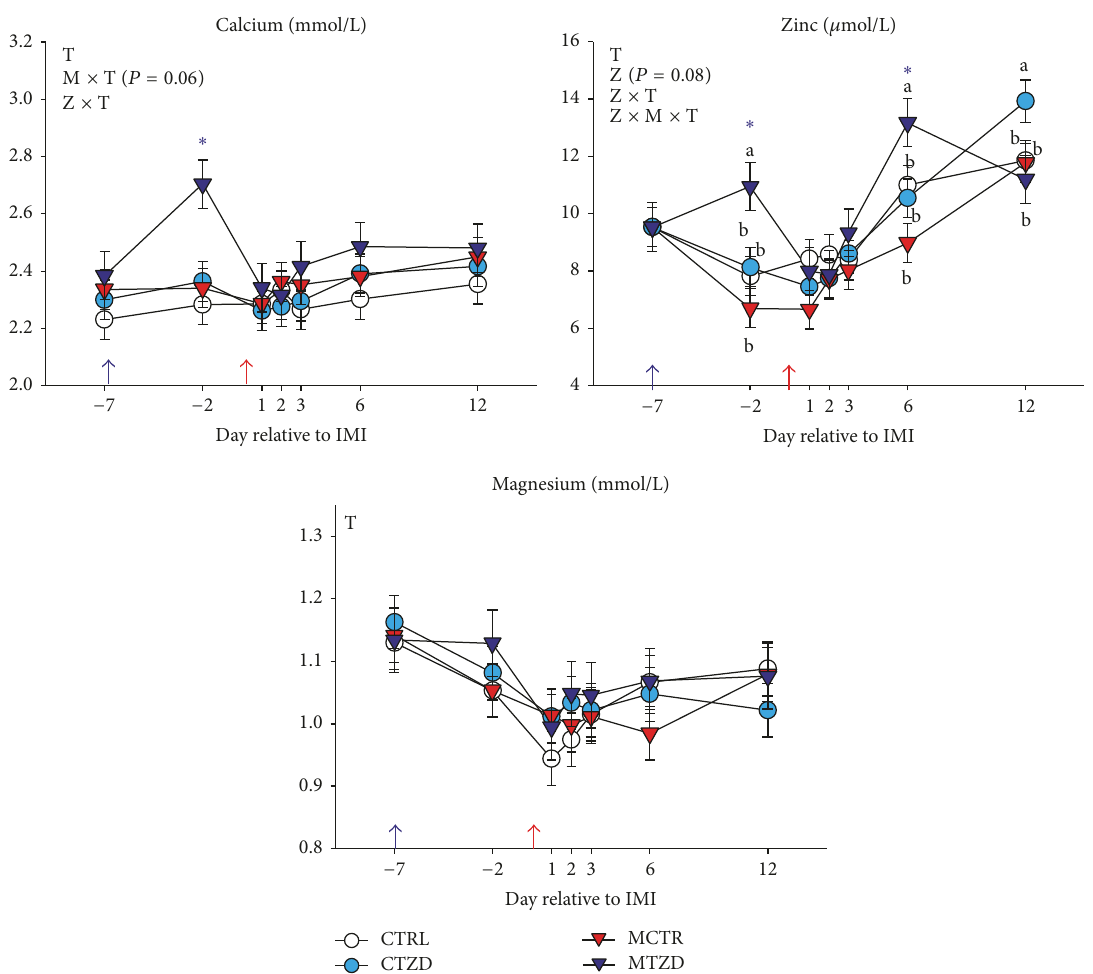
Figure 6: Plasma concentration of blood minerals from − 7 to 12d relative to intramammary infusion of Strep. uberis (M) or saline in goats receiving daily intrajugular injection of 2,4-thiazolidinedione (TZD) or saline (CTR). Significant ( 𝑃 ≤ 0.05 ) effects and interactions are indicated in the graph (mastitis: M, time: T, and TZD: Z). The 𝑃 value for tendency is reported. Significant effect Z × T is denoted with purple